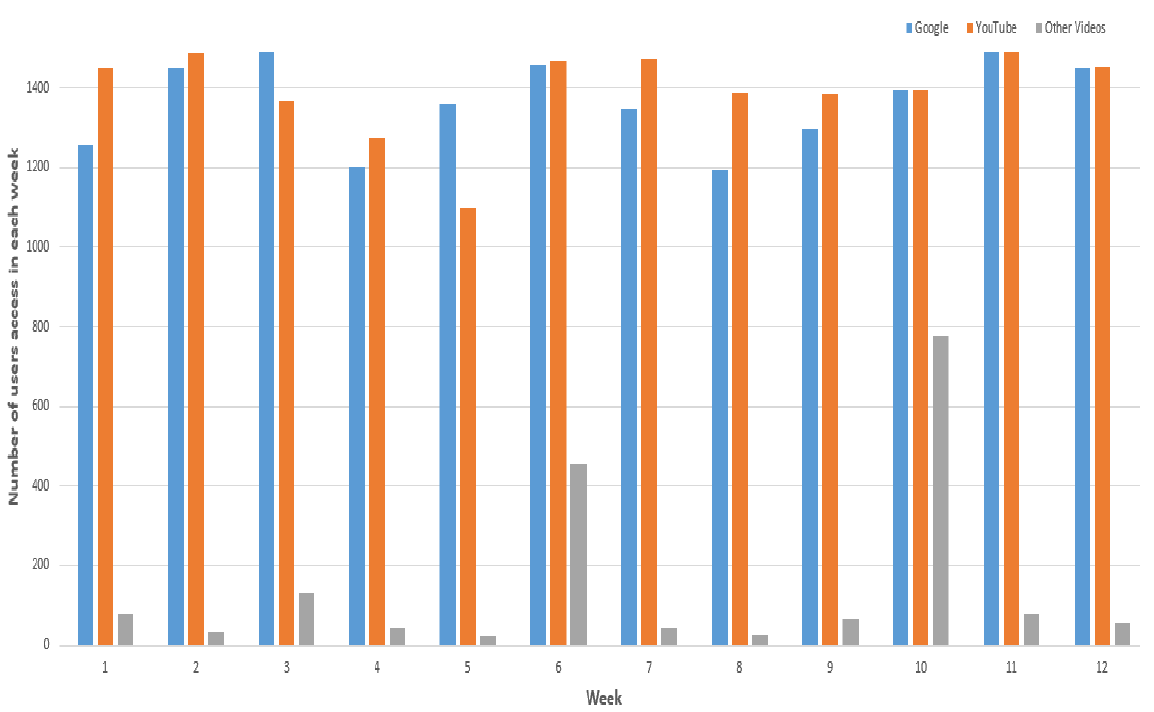
Figure 4. Number of users accessing videos each week.